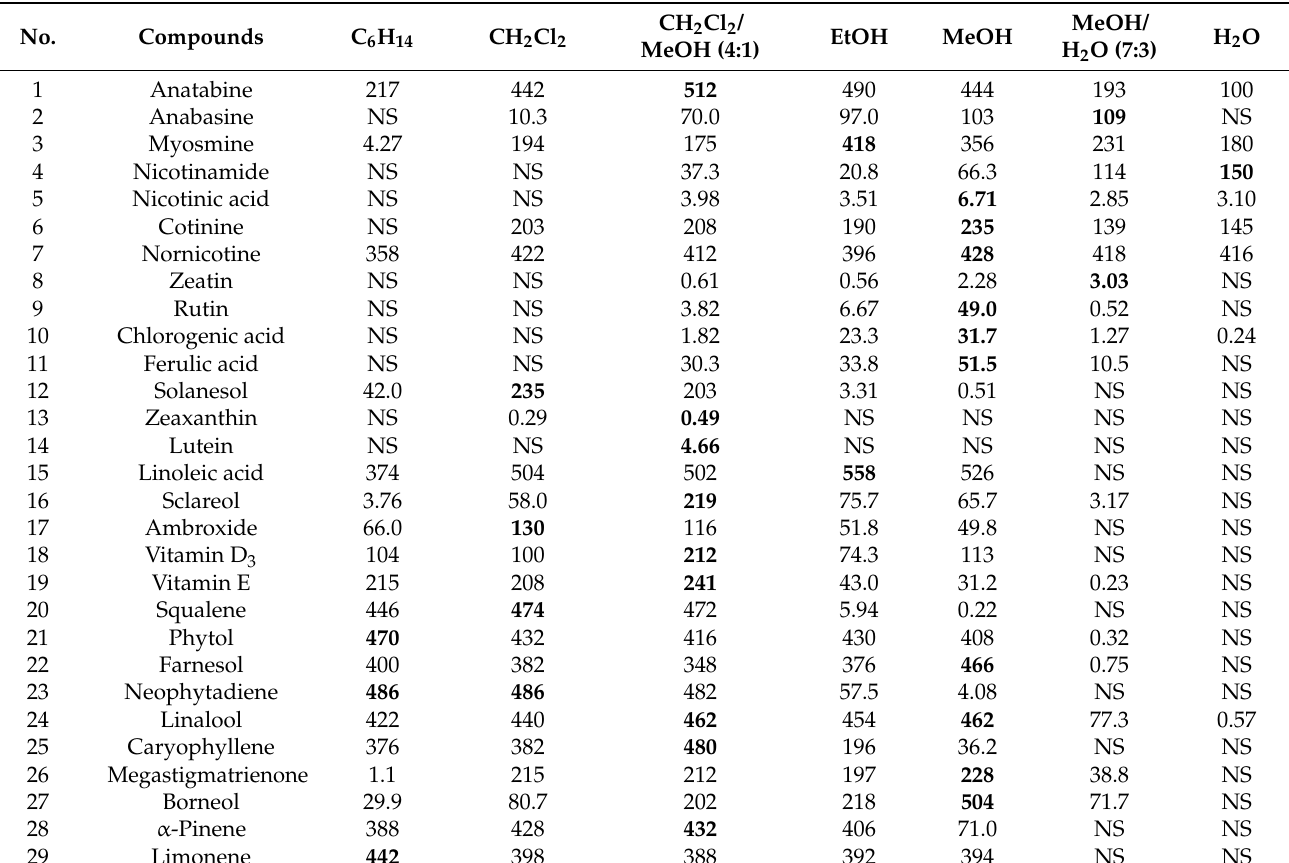
Table 1. Rapid solubility test results of 29 bioactive compounds in 7 different solvents (mg/mL, at room temperature (21–23 ◦